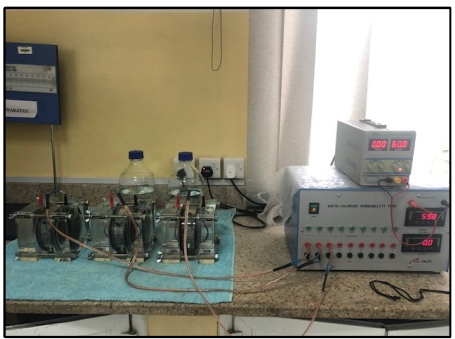
Figure 7. RCPT device.